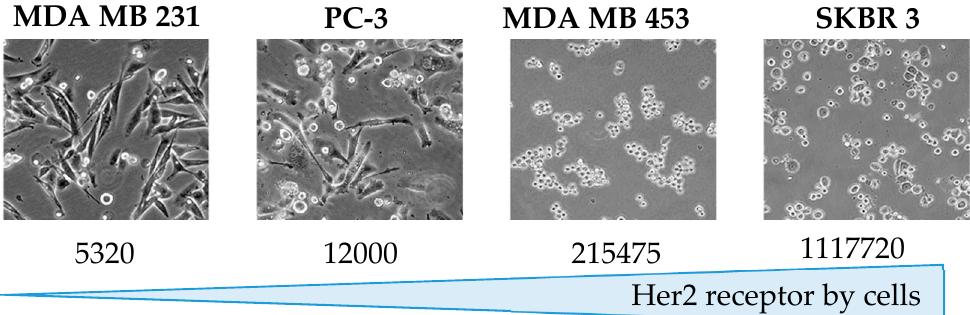
Figure 4. Comparison of Her2 receptors on cell surface for MDA-MB-231, PC-3, MDA-MB-453 and SKBR3.